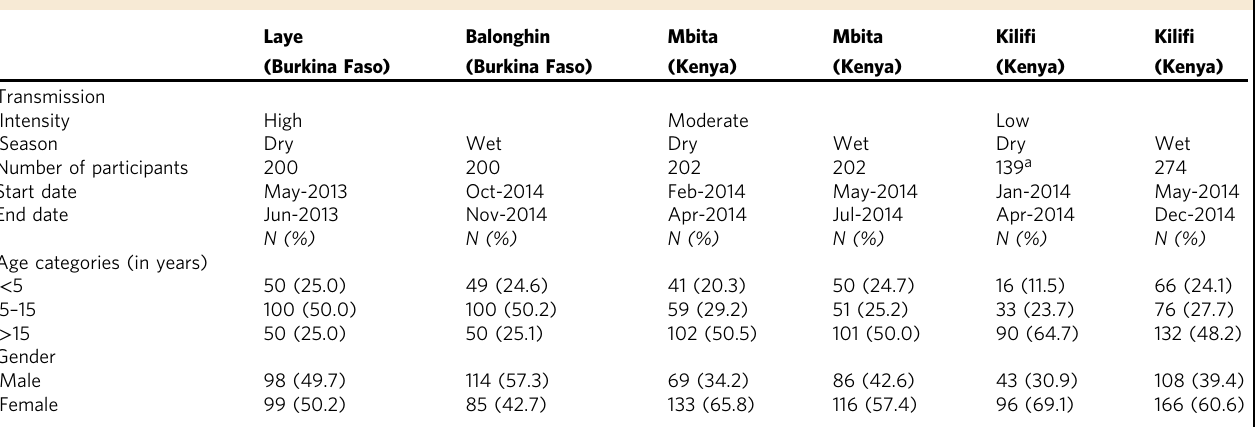
Table 1 Xenodiagnostic